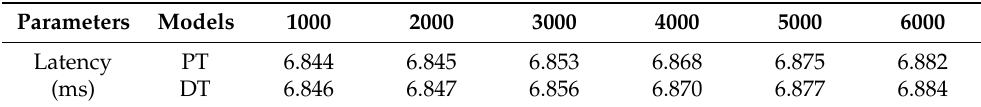
Figure 4. ( a ) DT Synchronization with PT; ( b ) CPU utilization. Table 3. Analysis of DT − PT Synchronization